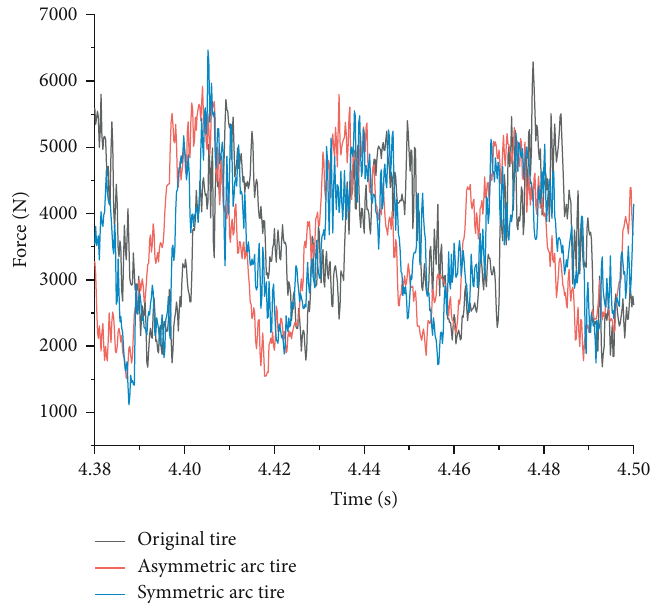
Figure 14: Comparison of time-domain distribution of radial excitation force of three kinds of tires.